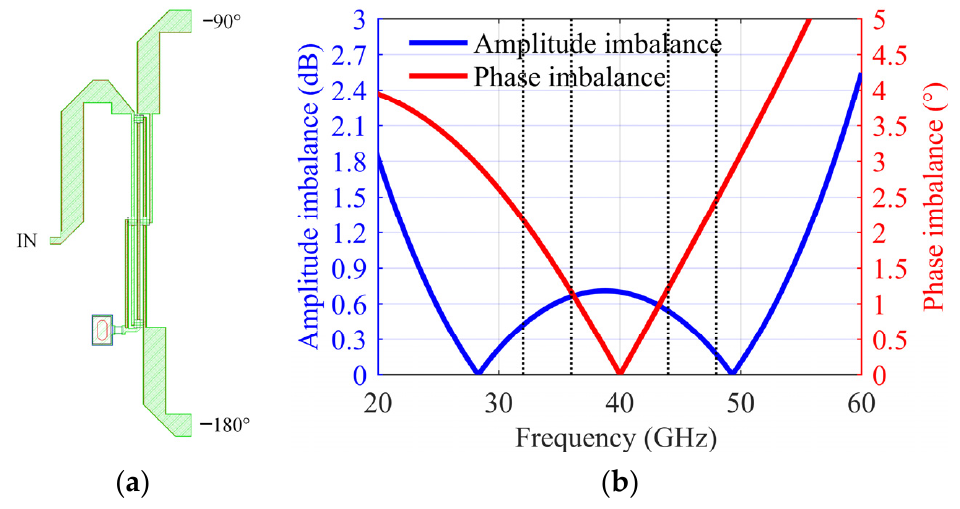
Figure 3. ( a ) Lange coupler simulation model; ( b ) Simulation results.